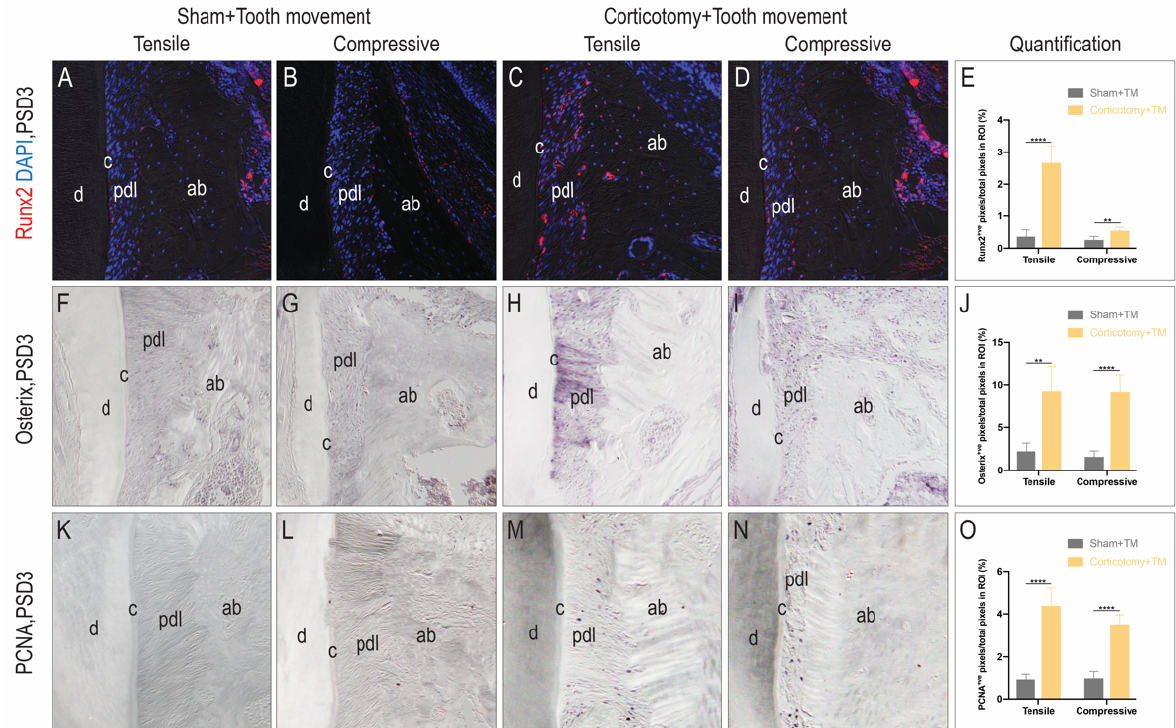
Figure 2. Representative sagittal tissue sections immunostained to detect pre-osteoblasts and cell proliferation on PSD 3. ( A ) Immunostaining with Runx2 on the tensile side of the Sham+TM group ( n = 12), ( B ) on the compressive side of the Sham + TM group ( n = 12), ( C ) on the tensile side of the Corti+TM group ( n = 12), and ( D ) on the compressive side of the Corti + TM group ( n = 12) (DAPI, blue; Runx2, red), quantified in ( E ). ( F ) Immunostaining with Osterix on the tensile side of the Sham+TM group ( n = 12), ( G ) on the compressive side of the Sham + TM group ( n = 12), ( H ) on the tensile side of the Corti + TM group ( n = 12), and ( I ) on the compressive side of the Corti + TM group ( n = 12), quantified in ( J ). ( K ) Immunostaining with PCNA on the tensile side of the Sham+TM group ( n = 12), ( L ) on the compressive side of the Sham + TM group ( n = 12), ( M ) on the tensile side of the Corti + TM group ( n = 12), and ( N ) on the compressive side of the Corti+TM group ( n = 12), quantified in ( O ). Abbreviations: ab: alveolar bone; pdl: periodontal ligament; d: dentin; c: cementum; PSD: post-surgery day; ROI: region of interest. *: p < 0.05; **: p < 0.01; ***: p < 0.001; ****: p < 0.0001. Scale bar = 50 μm for all panels.